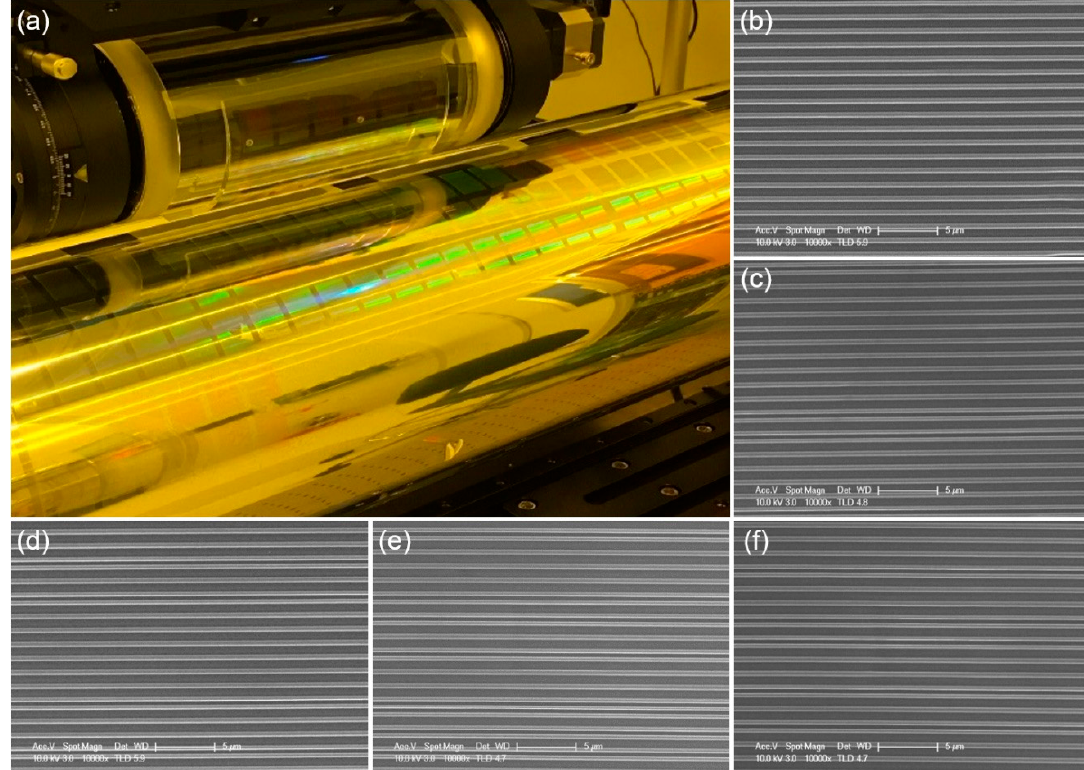
Figure 7. Photograph and SEM images of the patterned results on a large-area acceptor roll after 56 processes have been finished. ( a ) Photograph of the acceptor roll and the stamp roll; ( b – f ) SEM images measured at random locations on the PET film peeled off the acceptor roll. The lines are mounted in circumferential direction.